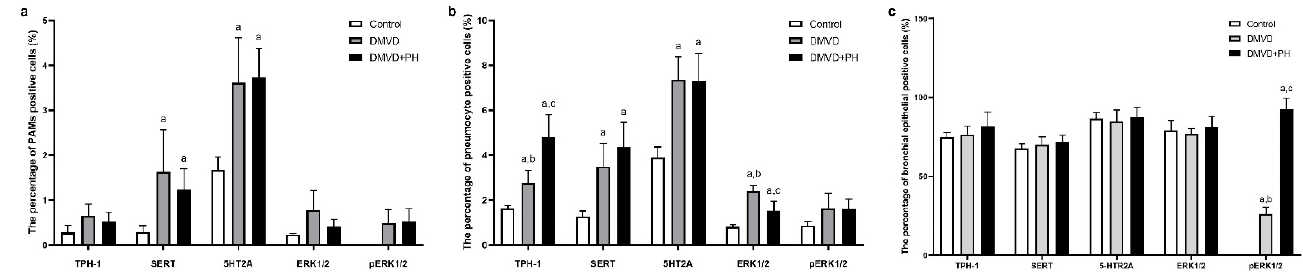
Figure 4. The expression of ERK1/2 and pERK1/2 in pneumocytes, PAMs (top row) and bronchial epithelial cells (bottom row) of dogs in the control ( a , d , g , j ), degenerative mitral valve disease (DMVD) ( b , e , h , k ) and degenerative mitral valve disease with pulmonary hypertension (DMVD with PH) groups ( c , f , i , l ) presented as brown color (Labeled streptavidin-biotin, Immunohistochem- istry, Mayer’s Hematoxylin counterstained, 400× magnification).